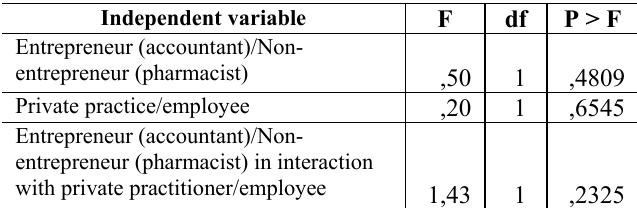
Table 2: Results of Analysis of Variance with the Achievement/Personal Control Sub-Scale as Dependent Variable